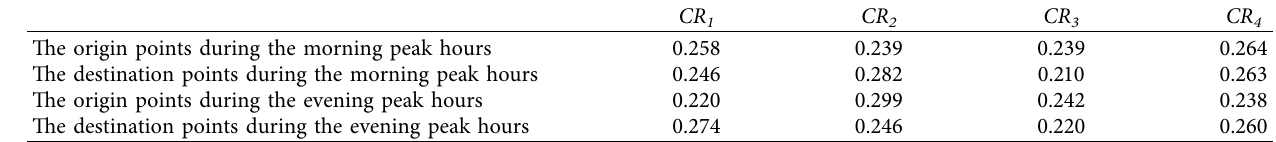
Table 3: Each reclassified category’s average CR of Cluster 0 during the morning and evening peak hours.